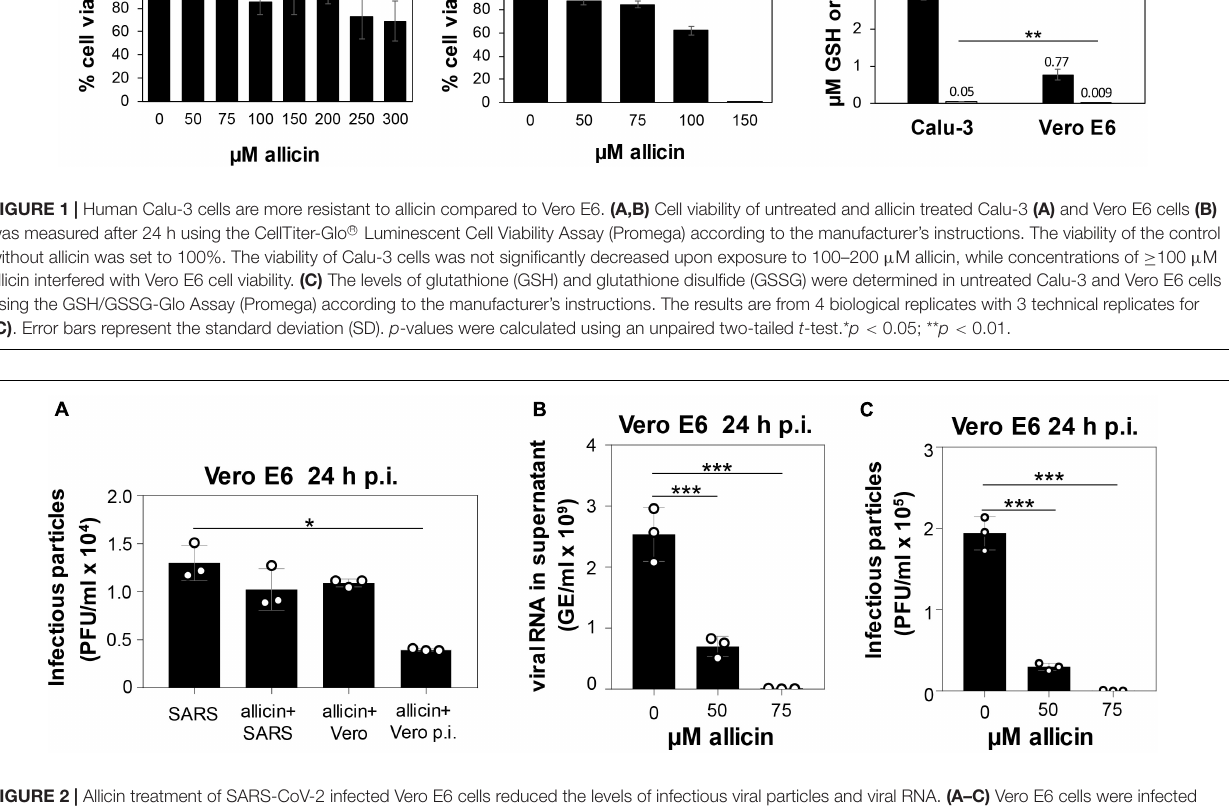
FIGURE 2 | Allicin treatment of SARS-CoV-2 infected Vero E6 cells reduced the levels of infectious viral particles and viral RNA. (A–C) Vero E6 cells were infected with SARS-CoV-2 at a MOI of 0.01. After 24 h p.i. viral replication was analyzed by determination of infectious viral particles or viral RNA in the supernatant. (A) Comparison of different allicin treatments: Untreated Vero E6 cells infected with SARS-CoV-2 as control (SARS); SARS-CoV-2 pre-treated with 50 µ M allicin for 30 min prior to infection of host cells (allicin + SARS); host cells pre-treated with 50 µ M allicin for 30 min prior to infection with SARS-CoV-2 (allicin + Vero); and SARS-CoV-2 infected host cells treated with 50 µ M allicin p.i. (allicin + Vero p.i.). (B,C) The amount of viral RNA (B) and infectious viral particles (C) was determined after treatment of SARS-CoV-2 infected Vero E6 cells with 50 and 75 µ M allicin p.i. The results (A–C) are from three biological replicates with two technical replicates for panel (B) . Error bars represent the SD. p -values were calculated using an unpaired two-tailed t -test.* p < 0.05; *** p <